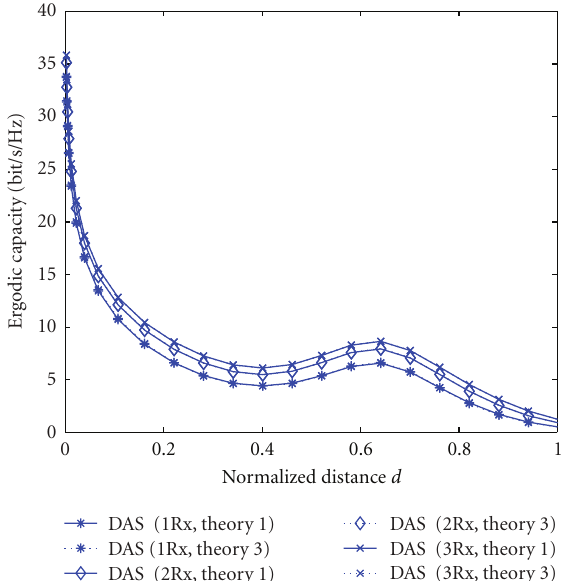
Figure 2: Comparison between exact and approximate ergodic ca- pacity.